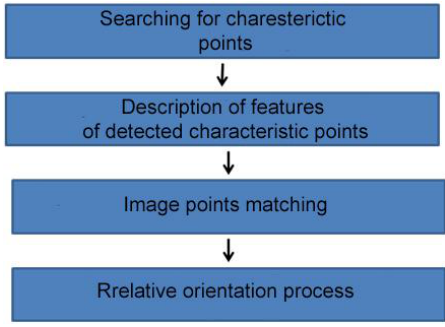
Fig. 1 Diagram of orientation of TLS data with the use of CV